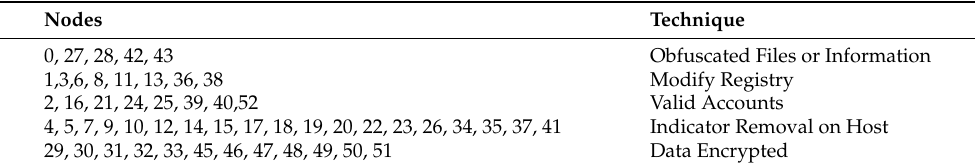
Table 5. Anti-forensic actions per node in the Use